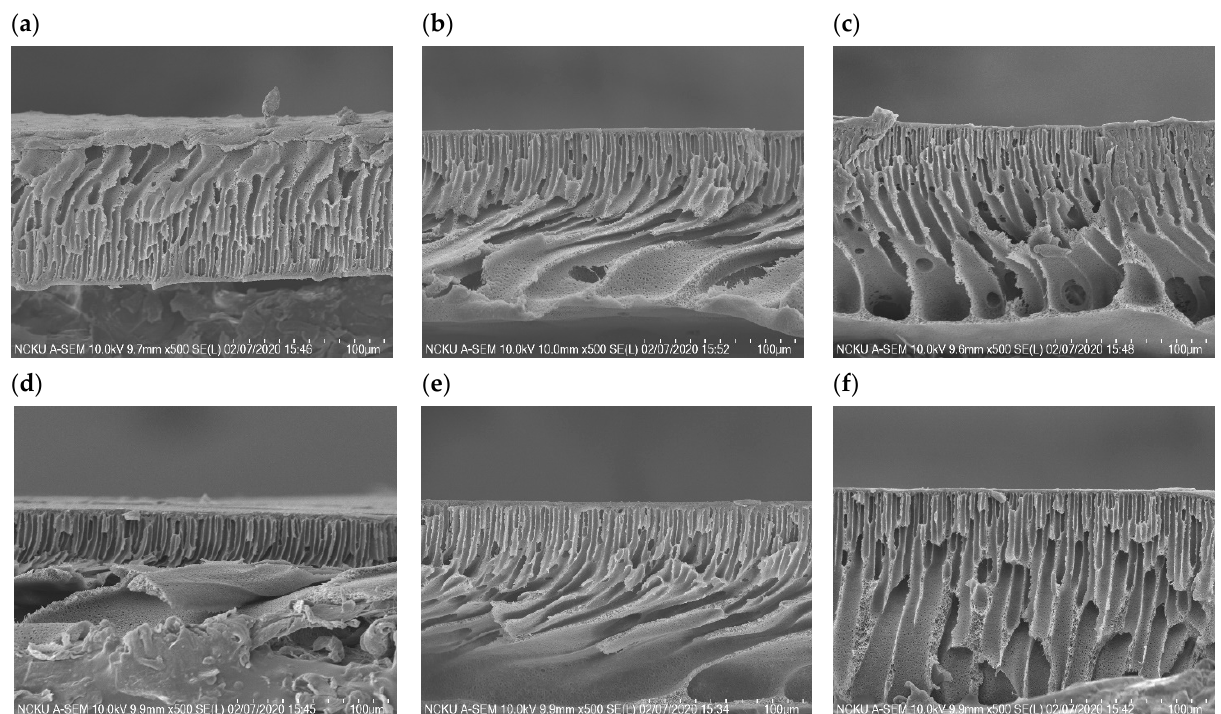
Figure 7. SEM morphologies of the cross sections of the TFN membranes using ( a ) CPA (0.2 wt.%), ( b ) CPB (0.2 wt.%), ( c ) CATCP (0.1 wt.%), ( d ) CBTCP (0.2 wt.%), ( e ) CATCP—TiO 2 (0.1 and 0.1 wt.%, respectively), and ( f ) CBTCP—TiO 2 (0.2 and 0.1 wt.%, respectively). Table 4. EDS analysis of TFN membranes.